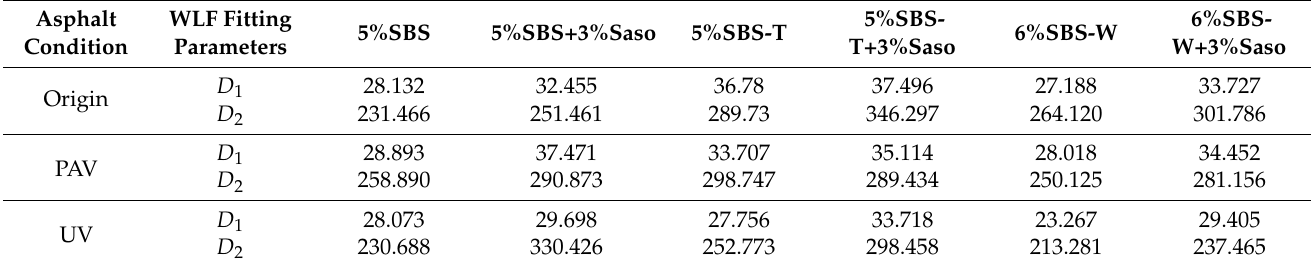
Table 6. Fitting parameters of WLF